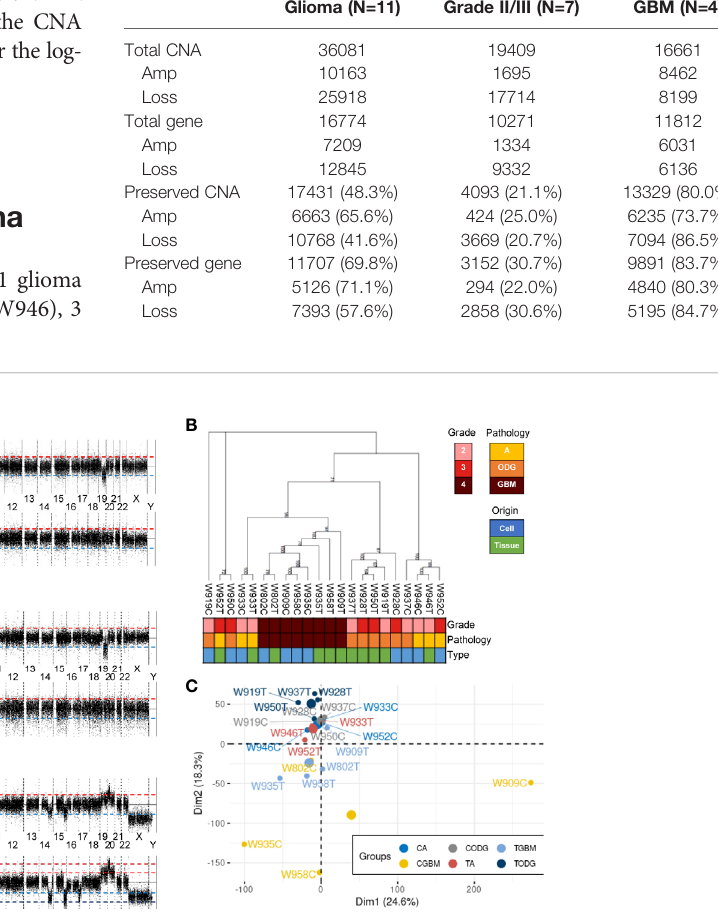
FIGURE 1 | Basic information of copy number variation (CNV) in glioma patient specimens and patient-derived primary cells. (A) Representative whole-genome views of CNV in different grades of glioma patient specimens and paired primary cells. Chromosome numbers are labeled between paired tissue and cell. T, patient tissue. C, patient-derived primary cell. (B) A maximum parsimony phylogenic tree for examining the relationship among patient samples and paired primary cells based on the differences of CNA events. A, astrocytoma; ODG, oligodendroglioma; GBM, glioblastoma. (C) PCA graph of sample similarity analysis based on CNA differences. Larger circles are mean points of each group. CA, astrocytoma-derived primary cells; CGBM, GBM-derived primary cells; CODG, oligodendroglioma- derived primary cells; TA, astrocytoma specimens; TODG, oligodendroglioma specimens; TGBM, GBM